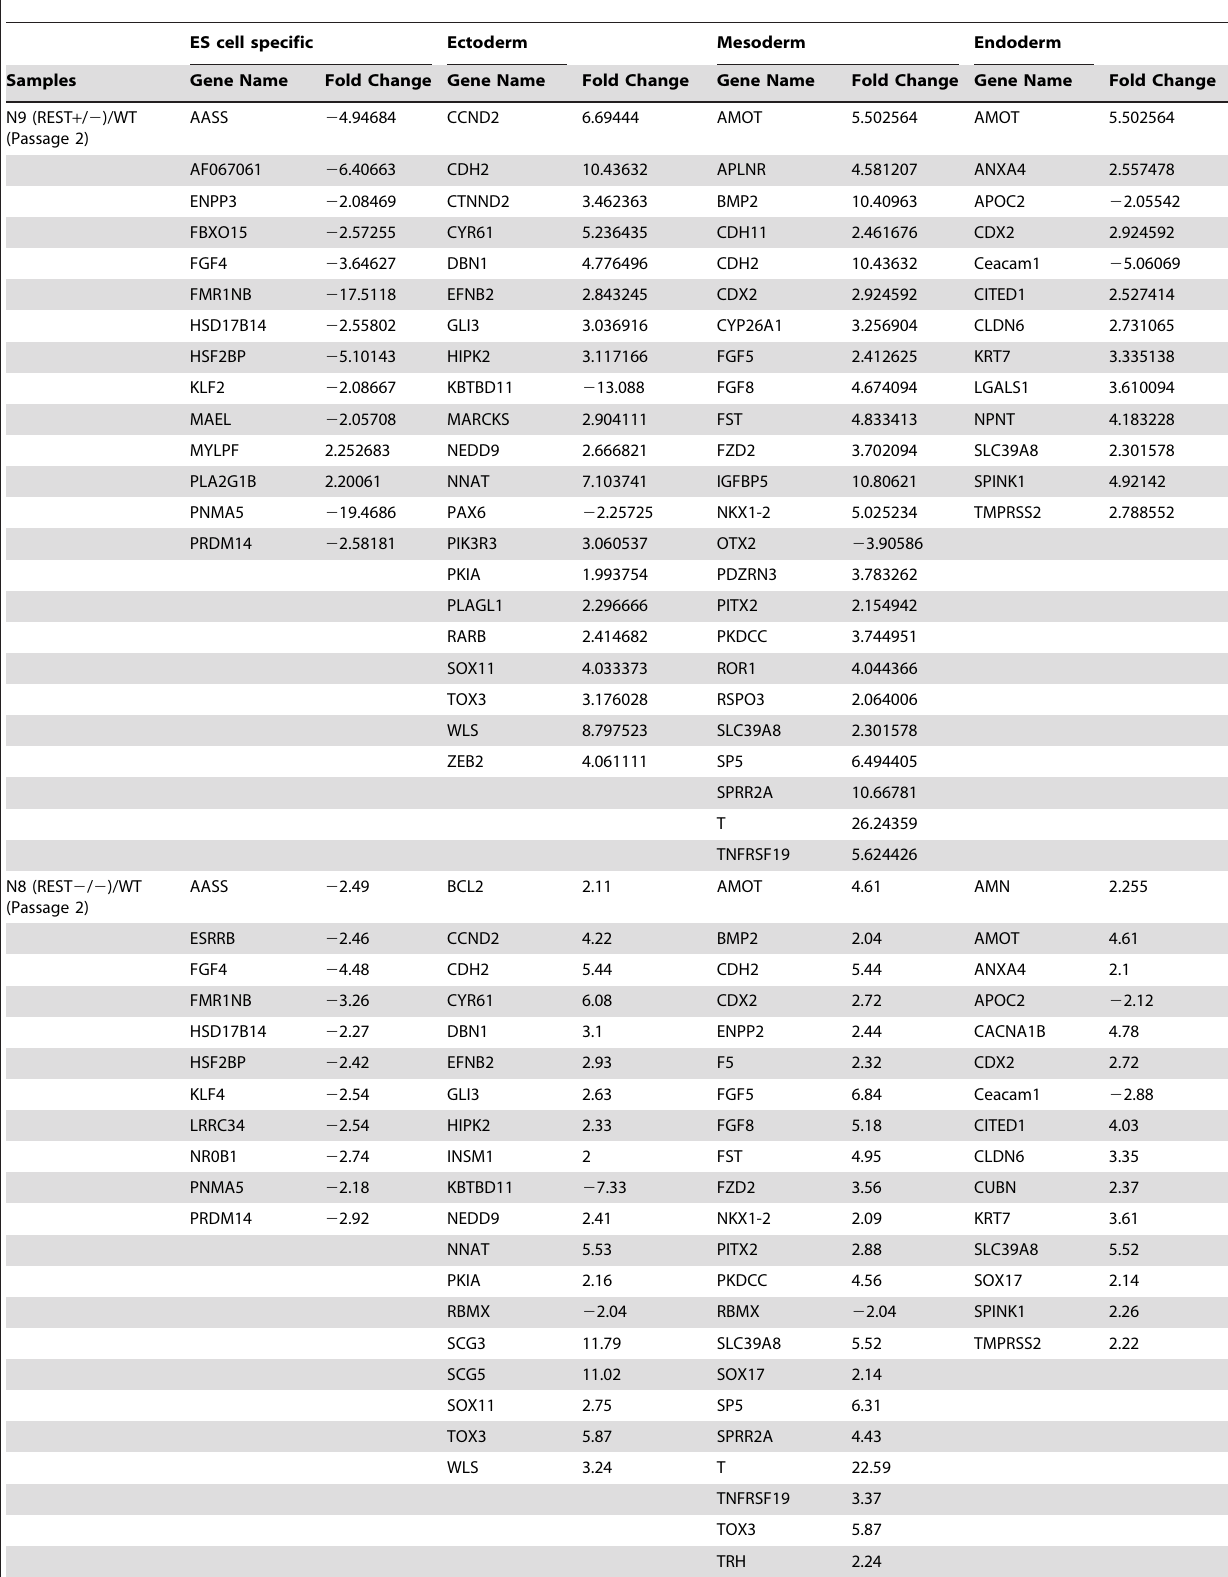
Table 1. Comparison of gene expression levels for N9 (Rest + / 2 )/N6 WT and N8 (Rest 2 / 2 )/N6 (WT) cultured on gelatin for passage